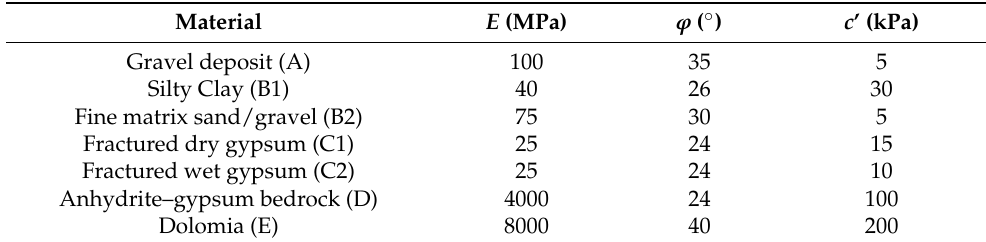
Table 3. Soil parameters for FEM analyses, where E , ϕ and c ’ state for Young modulus, friction angle and cohesion, respectively. Material E (MPa) ϕ ( ◦ ) c ’